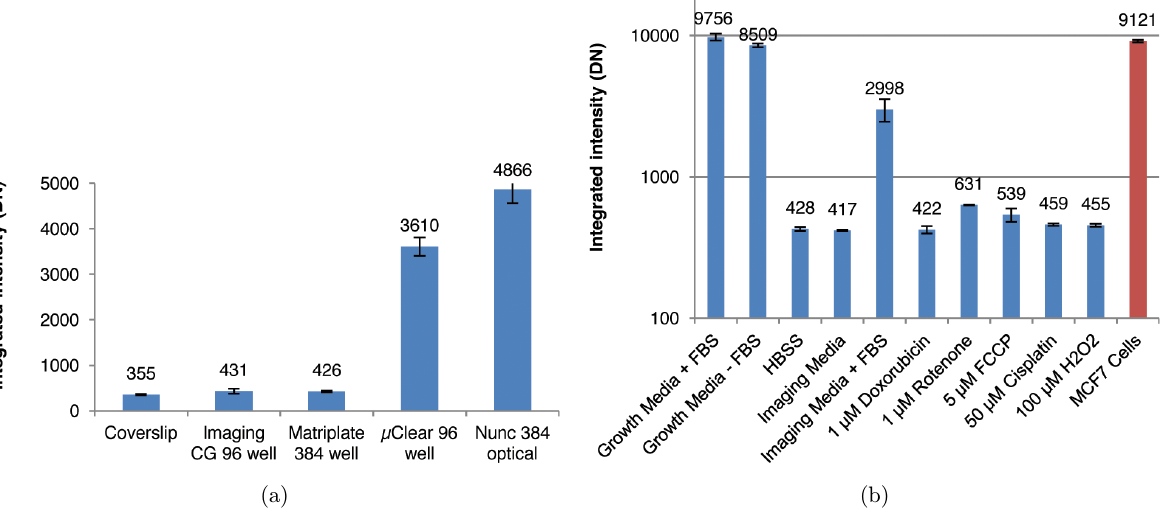
Fig. 2. Comparison of relative contributions from di®erent potential sources of background °uorescence. (a) Integrated °uor- escence intensity in units of camera digital numbers (DN) originating from a range of sample holders. (b) Comparison of background signal from media components and treatment compounds. Blue bars show integrated intensity originating from media components, including signal from Matriplate 384 well; red bar shows integrated intensity from MCF7 cells for comparison. Error bars show standard deviation across repeat